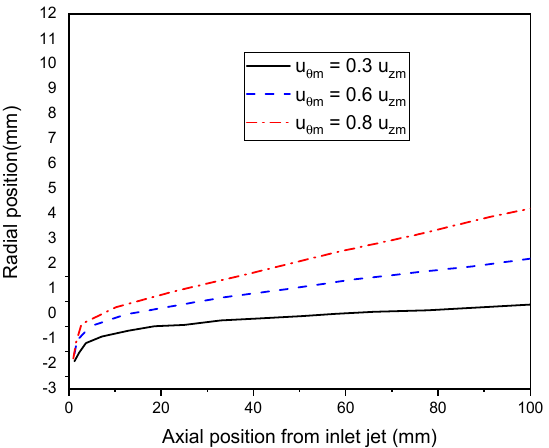
Figure 18. Trajectory of particles at different intensity of swirl flow of plasma jet (u θ m = 0.3 u zm , u θ m = 0.6 u zm, and u θ m = 0.8 u zm ).